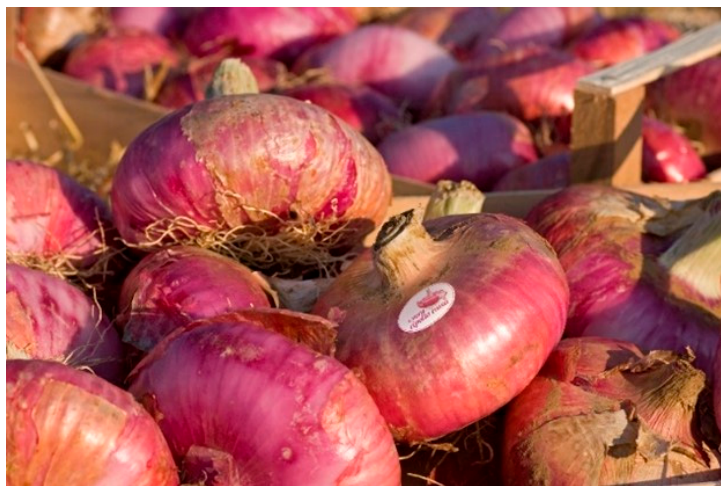
Figure 1. Bulbs of the “Cipolla di Acquaviva” landrace.